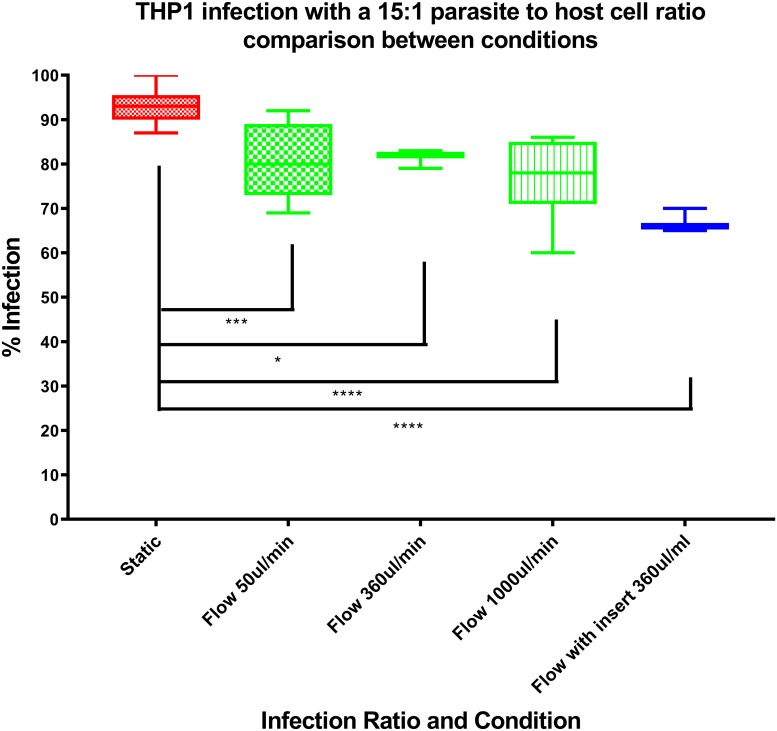
Influence of flow rate on percentage infection at a L. major promastigote to macrophage ratio of 15:1.